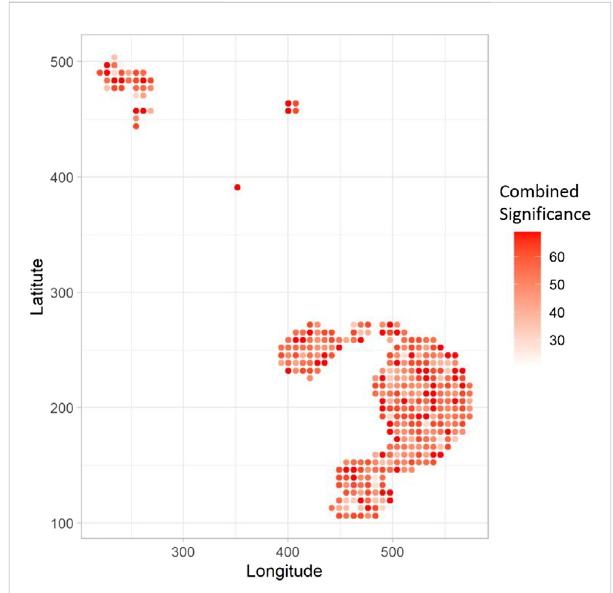
FIGURE 5 The spatial heatmap shows the Combined Signi fi cance (CS) of association of the 8 hallmarks with the COL11A1 phenotype at high CAFlevel.BiggerthevalueofCSatalocation,thecorrespondingpoint is shown in darker